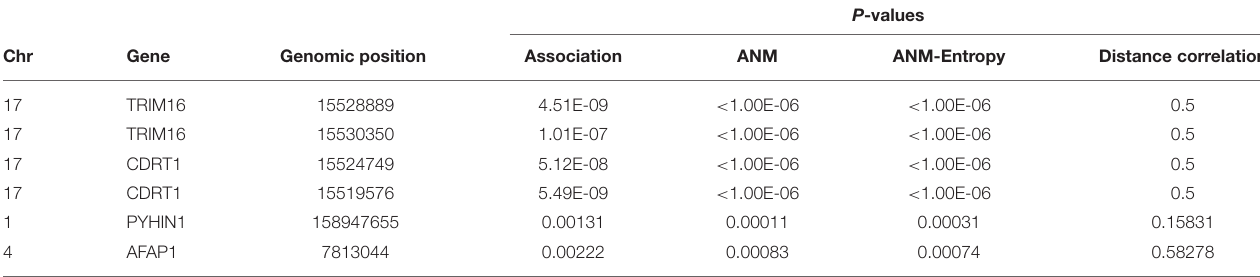
TABLE 5 | P -values for testing the causation and association of four SNPs with AD.